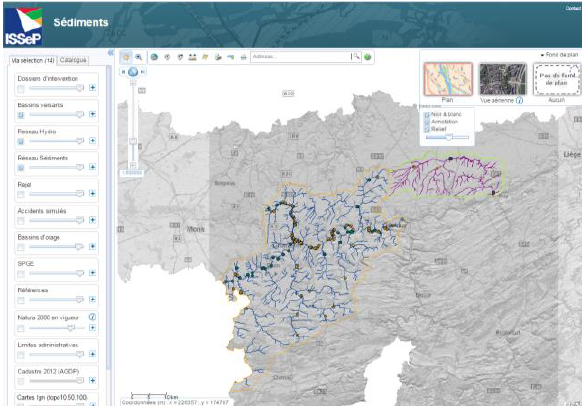
Figure 2. Area of Interest & WebGIS interface prototype